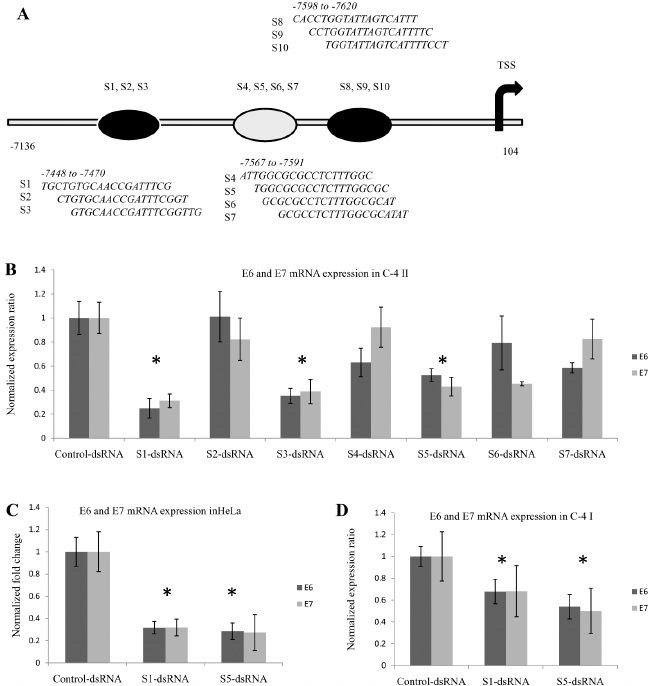
Fig 4. Screening of dsRNAs targeting HPV18 pRNAs. (A)Schematic representation of HPV18 LCR and the position of different dsRNA target sites. (B) C-4 II cells transfected with seven dsRNAs (100nM). C) S1 and S5 dsRNA transfection in HeLa cells (D) C-4 I cells transfected with S1 and S5 dsRNAs. Cells were transfected with the respective dsRNA and RNA was isolated 72 hours post transfection and analyzed by Real-Time RT-PCR. Expression ratio was calculated with respect to 18S rRNA, POLR2A, PPIA and β -actin by REST software and normalized to that of Control dsRNA. E6: Expression of E6 oncogene upon dsRNA transfection. E7: Expression of E7 oncogene upon dsRNA transfection. Control-dsRNA: Control dsRNA transfected cells, ( * ) P < 0.05.